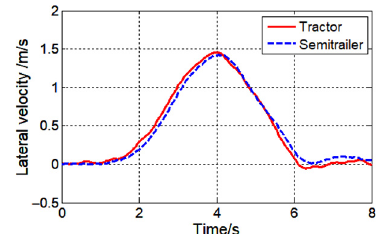
Figure 2 Vehicle lateral velocity test